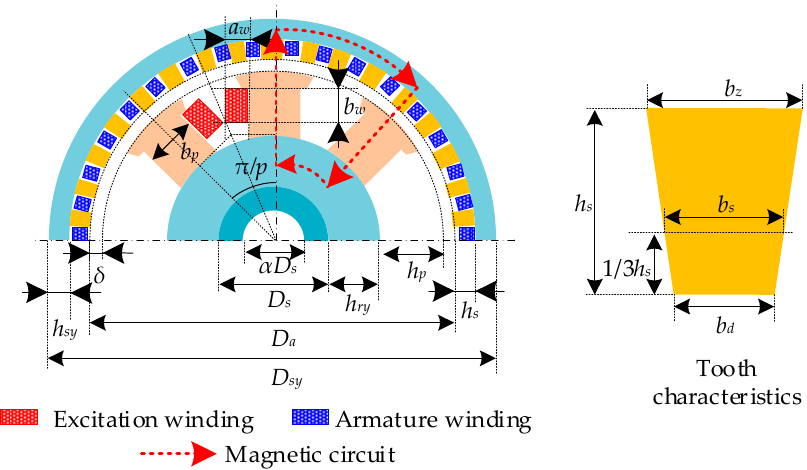
Figure 4. Structure of an electrically excited synchronous generator.